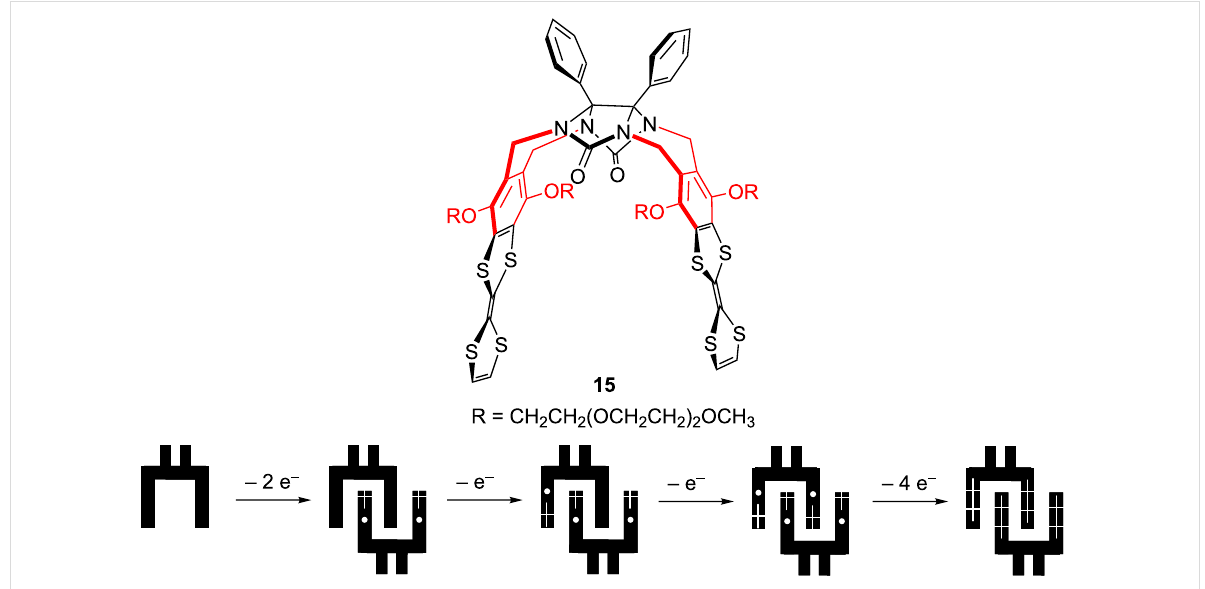
Figure 7: Molecular structure of molecular clip 15 and representation of its stepwise oxidation processes proposed by Chiu et al. [58].